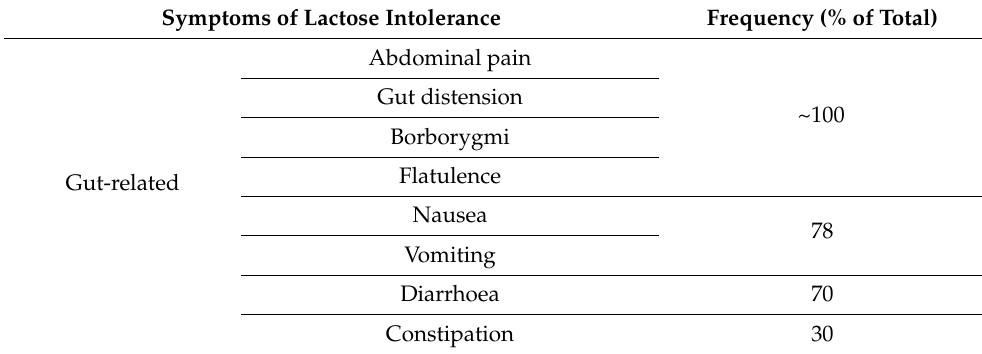
Table 2. Symptoms of lactose intolerance, based on